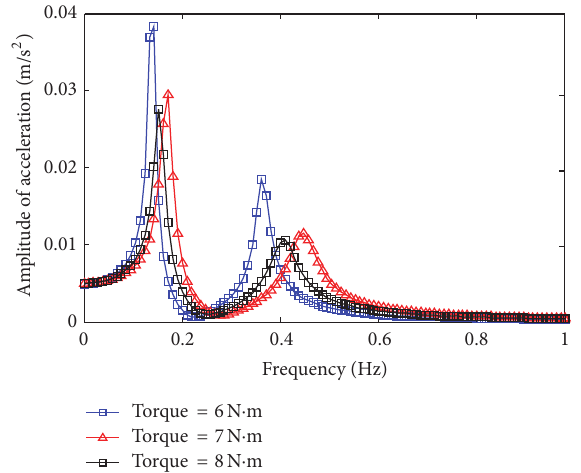
Figure7:Thecomparisonoffrequencyresponsecurvesfordifferent torques when the force amplitude 𝐹 exc = 100 N.